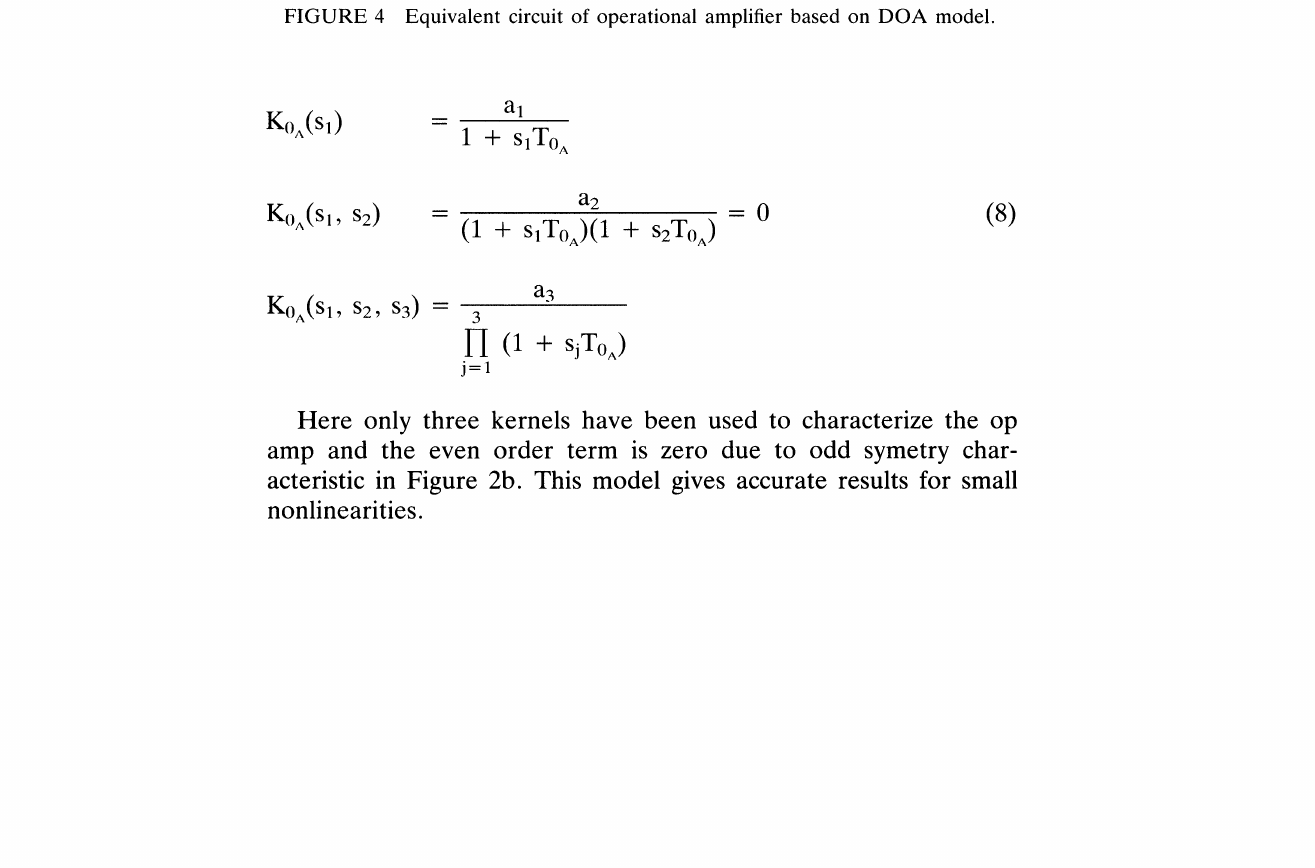
FIGURE 4 Equivalent circuit of operational amplifier based on DOA